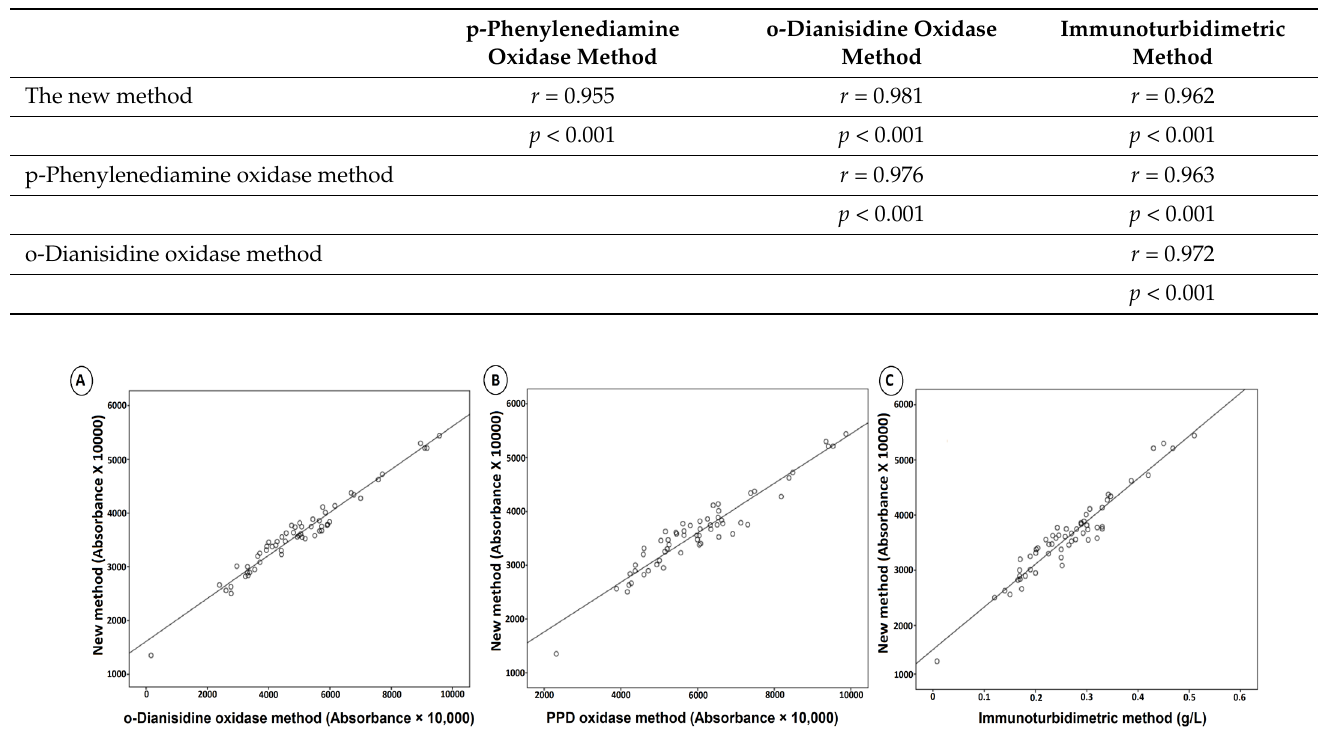
Figure 4. Comparison of the conventional serum ferroxidase/CP-measurement methods and the newly developed serum ferroxidase method in human blood serum. ( A ), the correlation between the new method and o-dianisidine oxidase method; ( B ), the correlation between the new method and p-phenylenediamine method; ( C ), the correlation between the new method and immunoturbidimetric method. Table 3. The relationship between the conventional CP oxidase measurement methods and the newly developed ferroxidase method ( n = 59) .